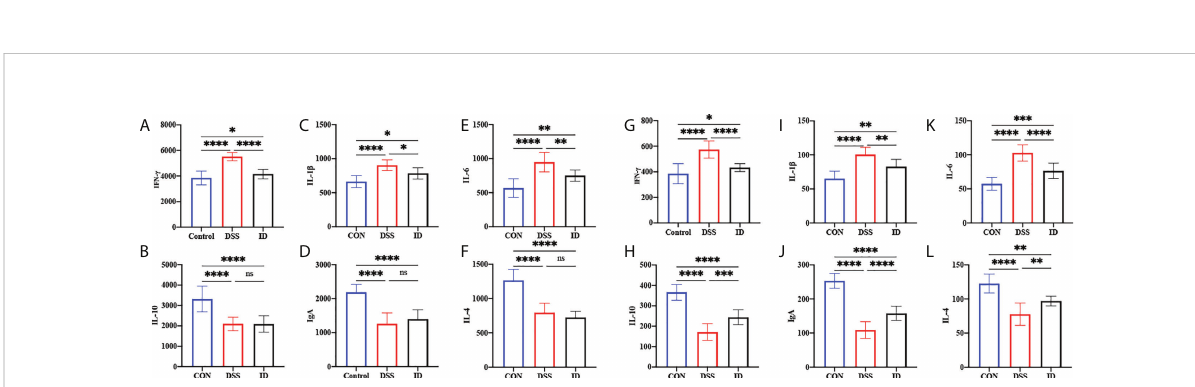
FIGURE 2 Effects ofIPA pretreatment onin fl ammatorycytokines and immunoglobulins of the serum and colon in DSS-induced colitis mice. The colonwas analyzed for the cytokines IFN- g (A) , IL-10 (B) , IL-1 b (C) , IgA (D) , IL-6 (E) , and IL-4 (F) . The serum was analyzed for cytokines IFN- g (G) , IL-10 (H) , IL-1 b (I) , IgA (J) , IL-6 (K) , and IL-4 (L) . All values areexpressedas the mean ± SEM (n= 9). P >0.05 (ns), P <0.05 (*), P <0.03 (**), P <0.01 (***), P <0.0001(****).